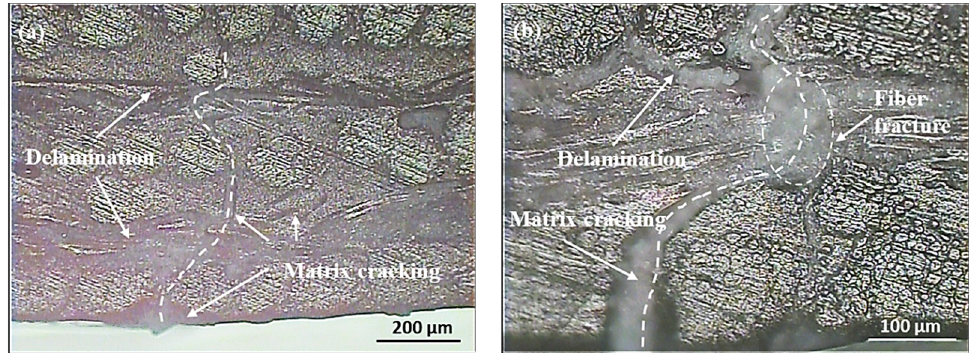
Figure 3. The appearances of FFRP laminate following an impact energy of 5 joules.